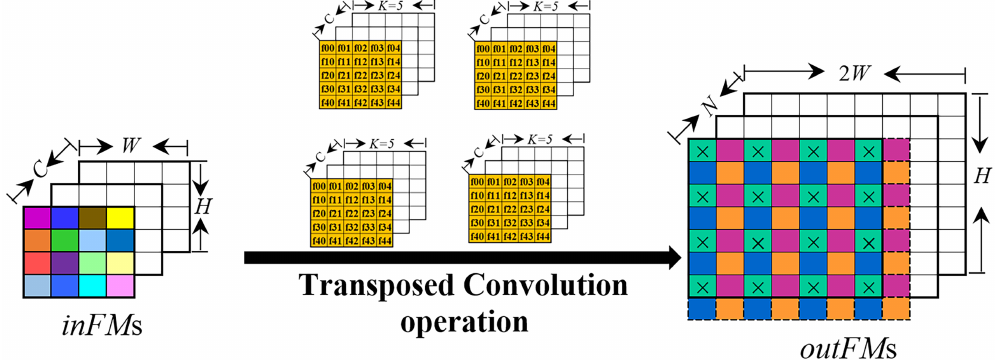
Figure 2. Data processing flow of transposed convolution layer.